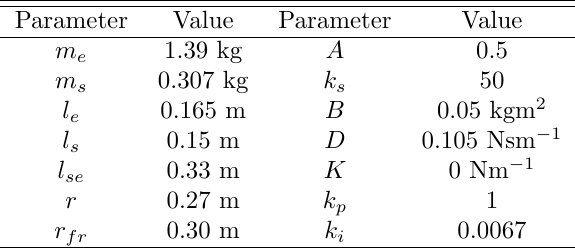
Table 1: Exoskeleton and control parameters